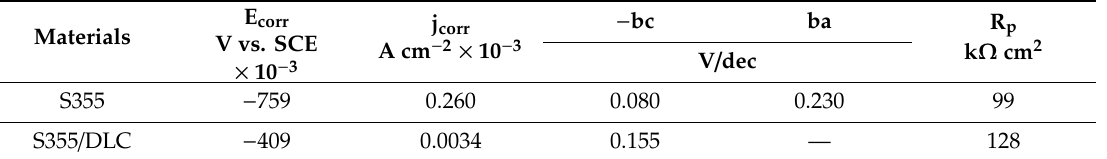
Table 1. Parameters of electrochemical corrosion, and polarization resistance of the S355 steel electrode, with and without a diamond-like carbon coating, at a temperature of 25 ◦